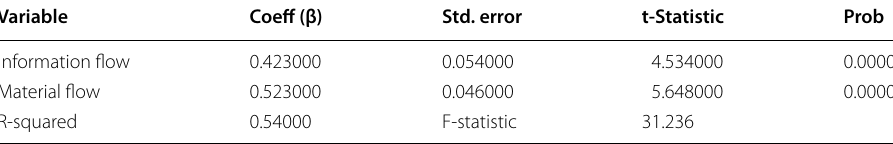
Table 5 Regression analysis of information and material flow on supply chain performance